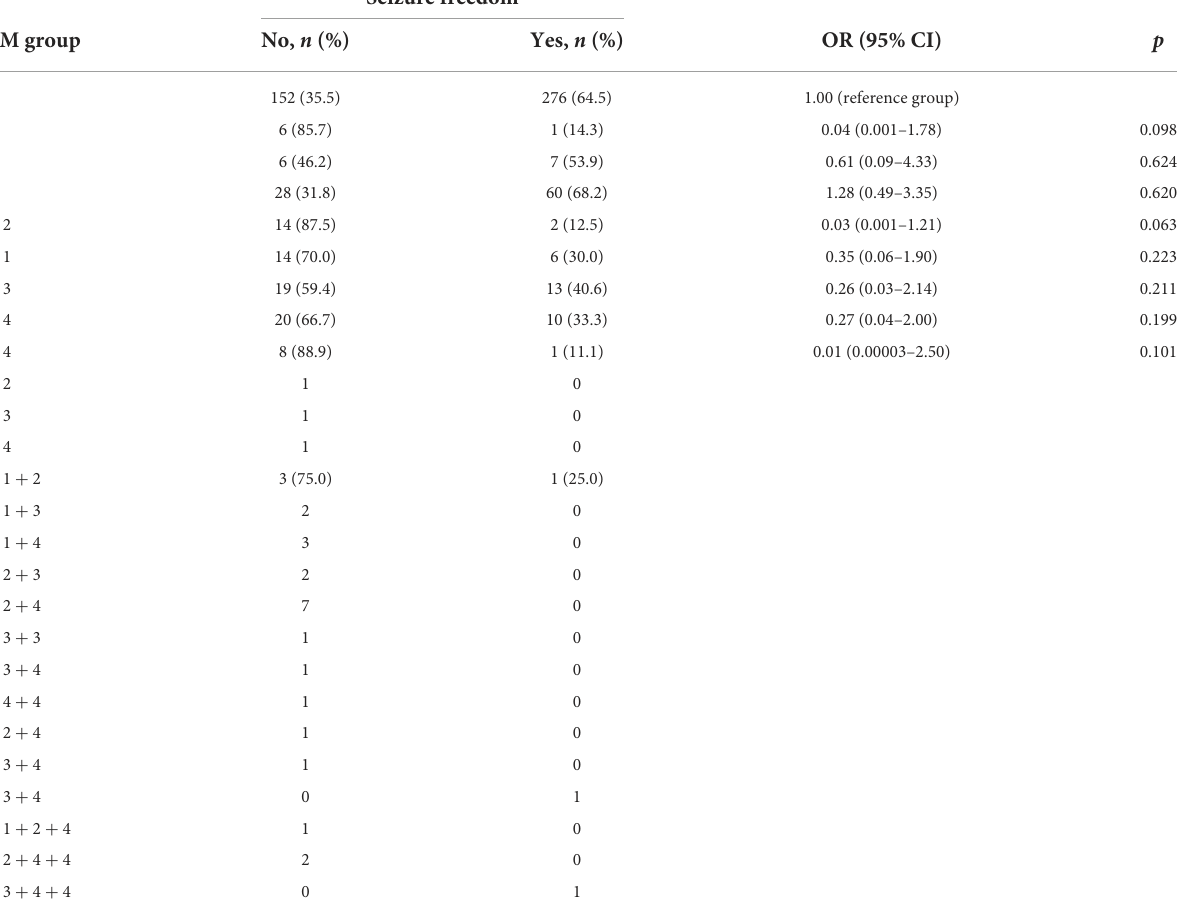
TABLE 7 Efficacy of antiseizure medications by different groups based on mechanism of action. Seizure